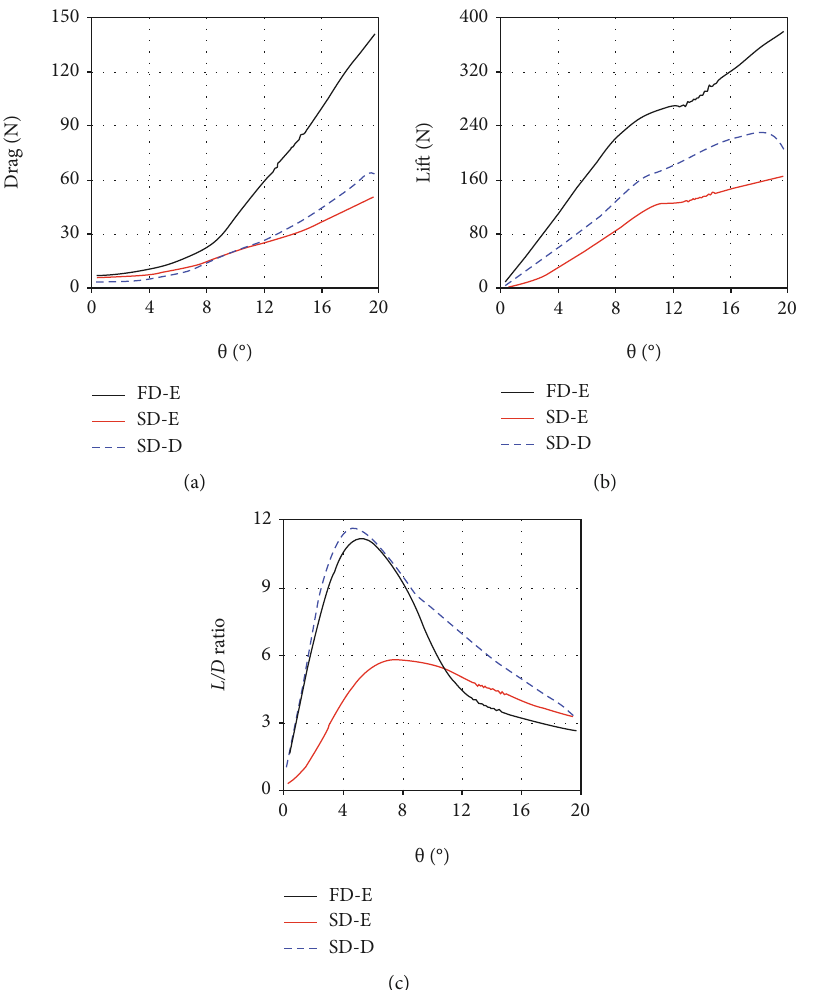
Figure 5: The drag, lift, and L / D ratio of the fi rst dorsal (FD) and second dorsal (SD) fi n in the erection and depression states under the quasi- static yaw motion ( ω = 0 : 01 rad/s): (a) the drag of the two dorsal fi ns; (b) the lift of the two dorsal fi ns; (c) the L / D ratio of the two dorsal fi ns. Note: FD-E represents the erection state of the fi rst dorsal fi n; SD-E (or SD-D) represents the erection (or depression) state of the second dorsal fi